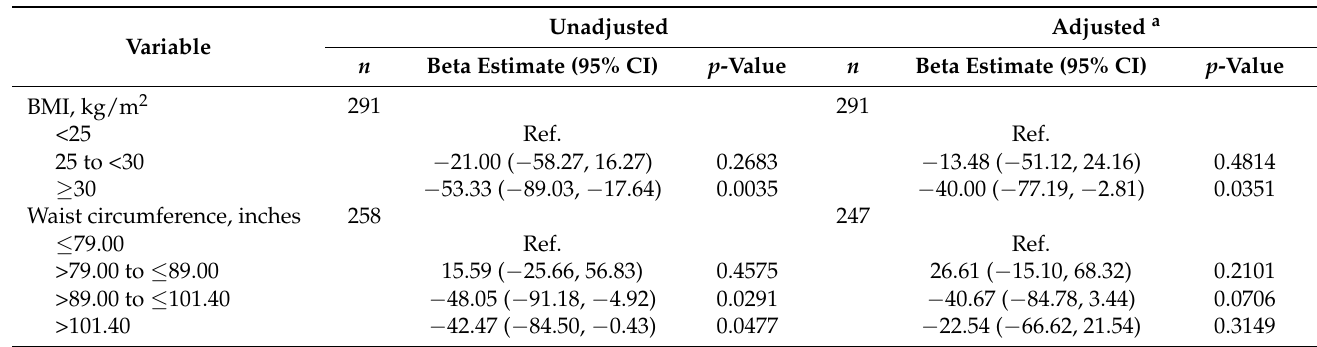
Table 4. Associations of body size and body composition measures with urinary creatinine-corrected triclosan